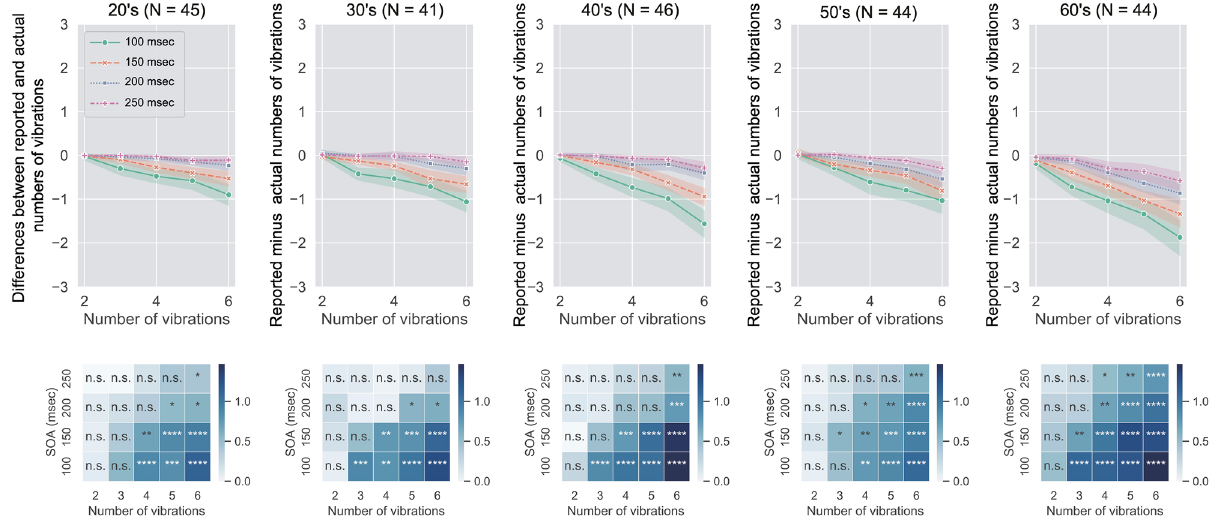
Figure 2. Upper: Mean difference between actual and reported numbers of vibrations as a function of the number of actual vibrations. The data of the 20’s, 30’s, 40’s, 50’s and 60’s age bands are plotted from left to right in Fig. 2. The error bars denote 95% confidence intervals though error bars are not visible because the intervals are so small. Lower: Heatmap of Cohen’s d for each age band. Asterisks (*p < .05, **p < .01, ***p < .001, ***p < .0001) denote the significance level (with correction by the Holm’s method) of one-sample t-tests for the mean difference with an array of zeros. n.s. denotes non-significance. Each graph shows the difference as a function of the number of vibrations for each SOA